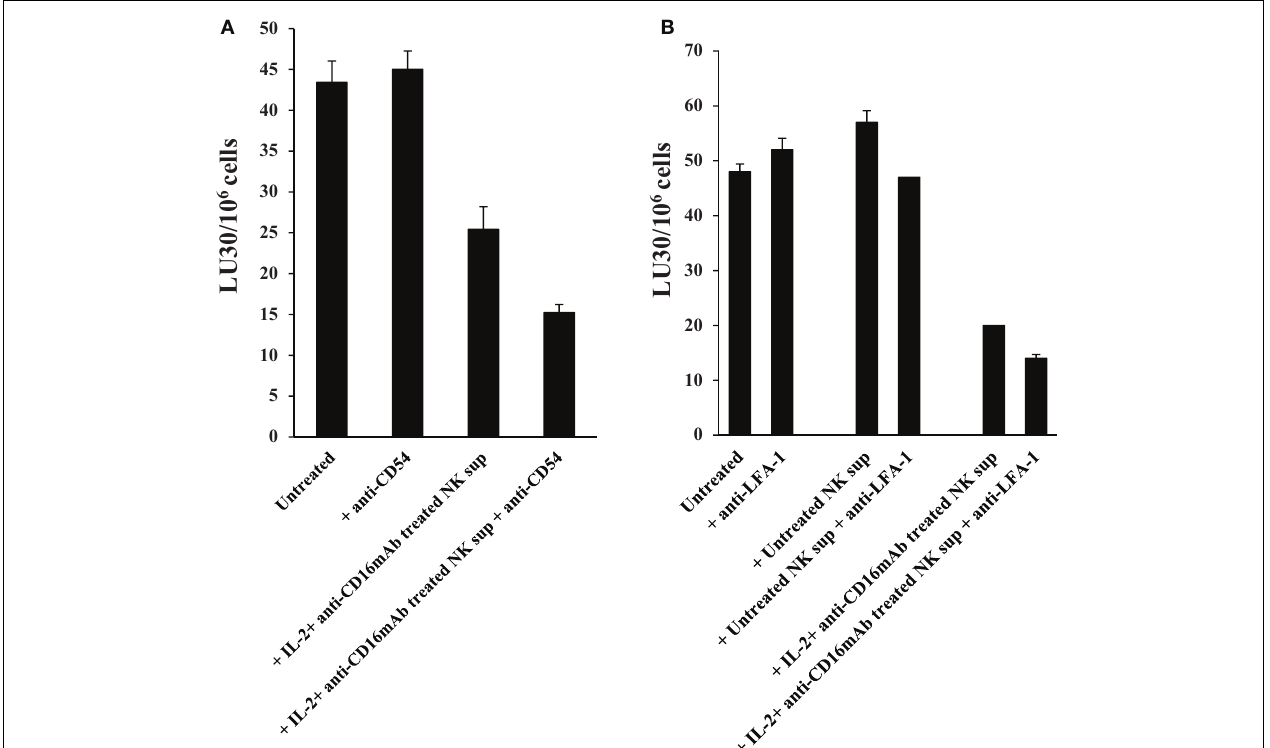
mAb (10 µ g/ml) (A) and anti-LFA-1 (1:100) (B) for 5days.Treated OSCSCs were then washed extensively and used in a standard 4h 51 Cr release assay against IL-2-activated (1000units/ml) NK cells. Pre-treatment of NK cells with IL-2 were carried out for 18–24h. Percent cytotoxicity was determined at different effector to target ratio, and the lytic units 30/10 6 cells were determined using inverse number of NK cells required to lyse 30% of the tumor cells ×